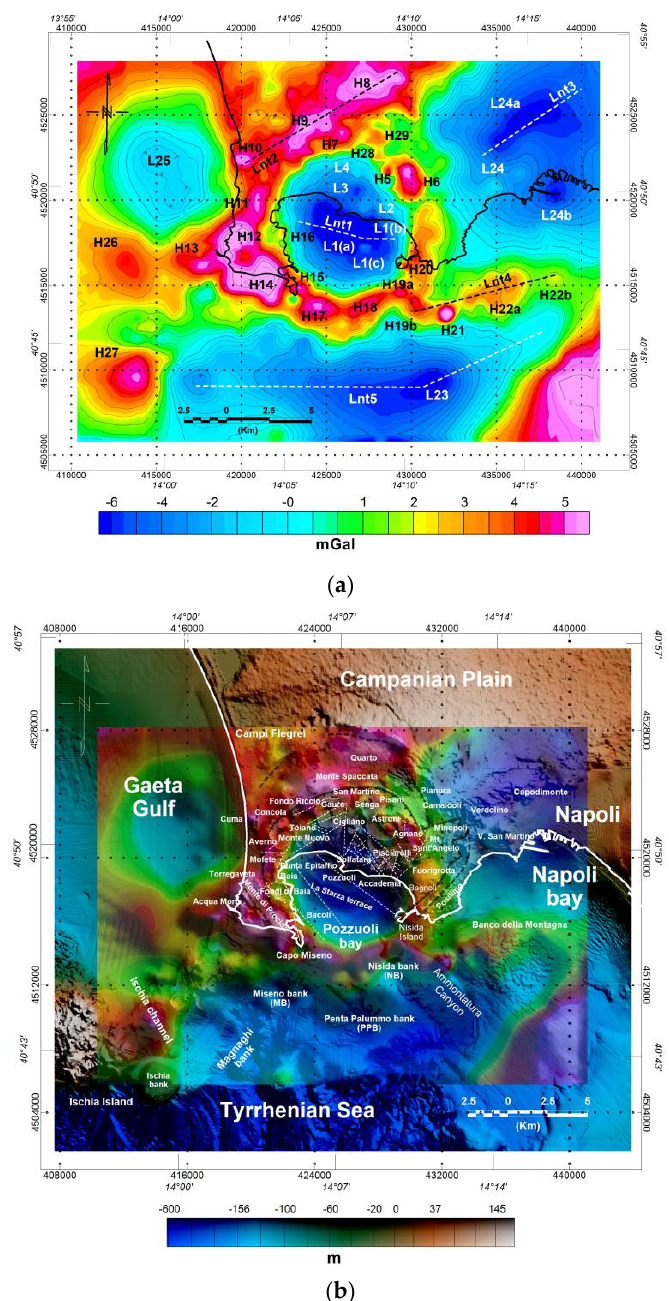
Figure 8. VPmg Residual Complete Bouguer anomaly map after removing the regional component; interpreted anomalies and their alignments are labelled with progressive number respectively (H-gravimetric high, L-gravimetric low and Lnt linear clustering of features) ( a ). Residual Complete Bouguer anomaly overlaid on the Digital Elevation Model, the figure shows the name of the main localities together with the inner (Yellow Tuff in dashed black lines) and the outer (Ignimbrite Cam- pana in dashed black half thick right lines) caldera rims as derived by Vitale and Isaia [22]. The faults displayed in Figure 1 are also reported in dashed white lines ( b ).